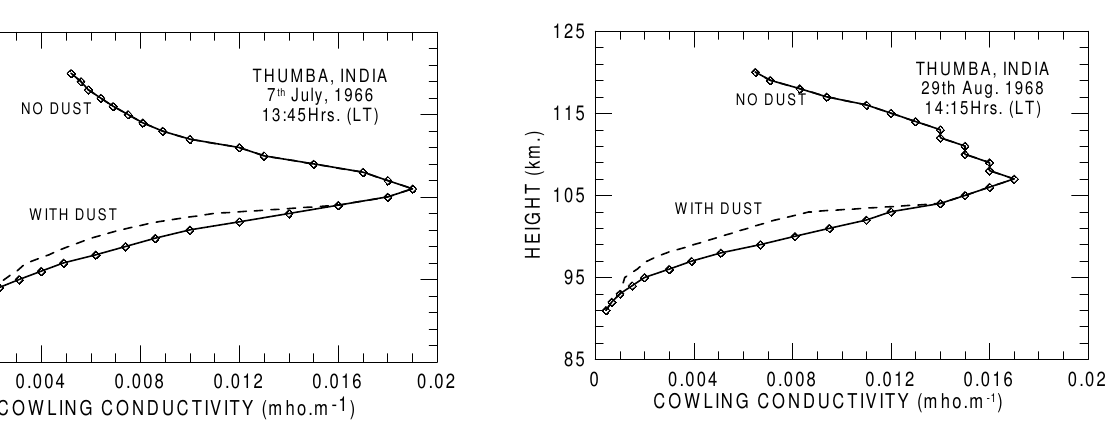
Fig. 7. Height profile of the Cowling conductivity on 29 August 1968 at 14:15 LT with and without an assumed charged dust layer.